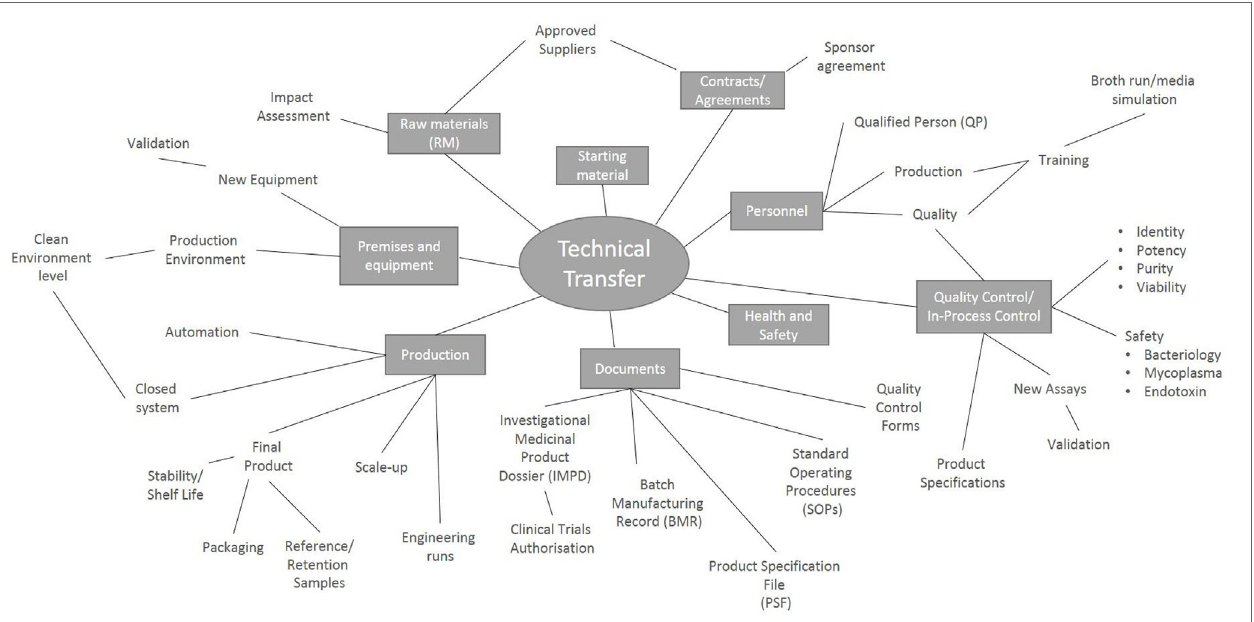
FiGURe 1 | Key points to consider during a technical transfer process. Schematic representation of the processes involved during the transfer of a manufacturing process from the research laboratory into a Good Manufacturing Process